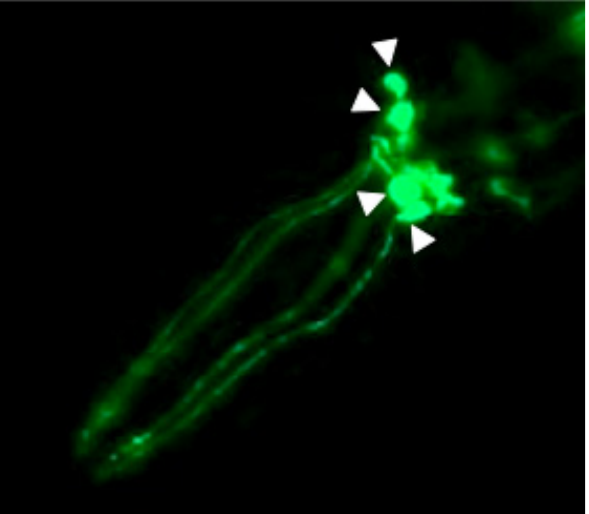
Figure 1. Arrowheads indicate the four dopaminergic cephalic (CEP) neurons in the head of the worm, with dendritic processes extending down to the tip of the